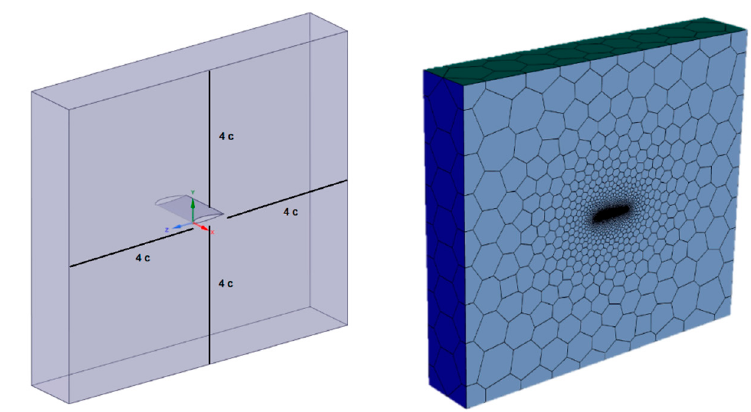
Figure 5. Computational domain and mesh overview.